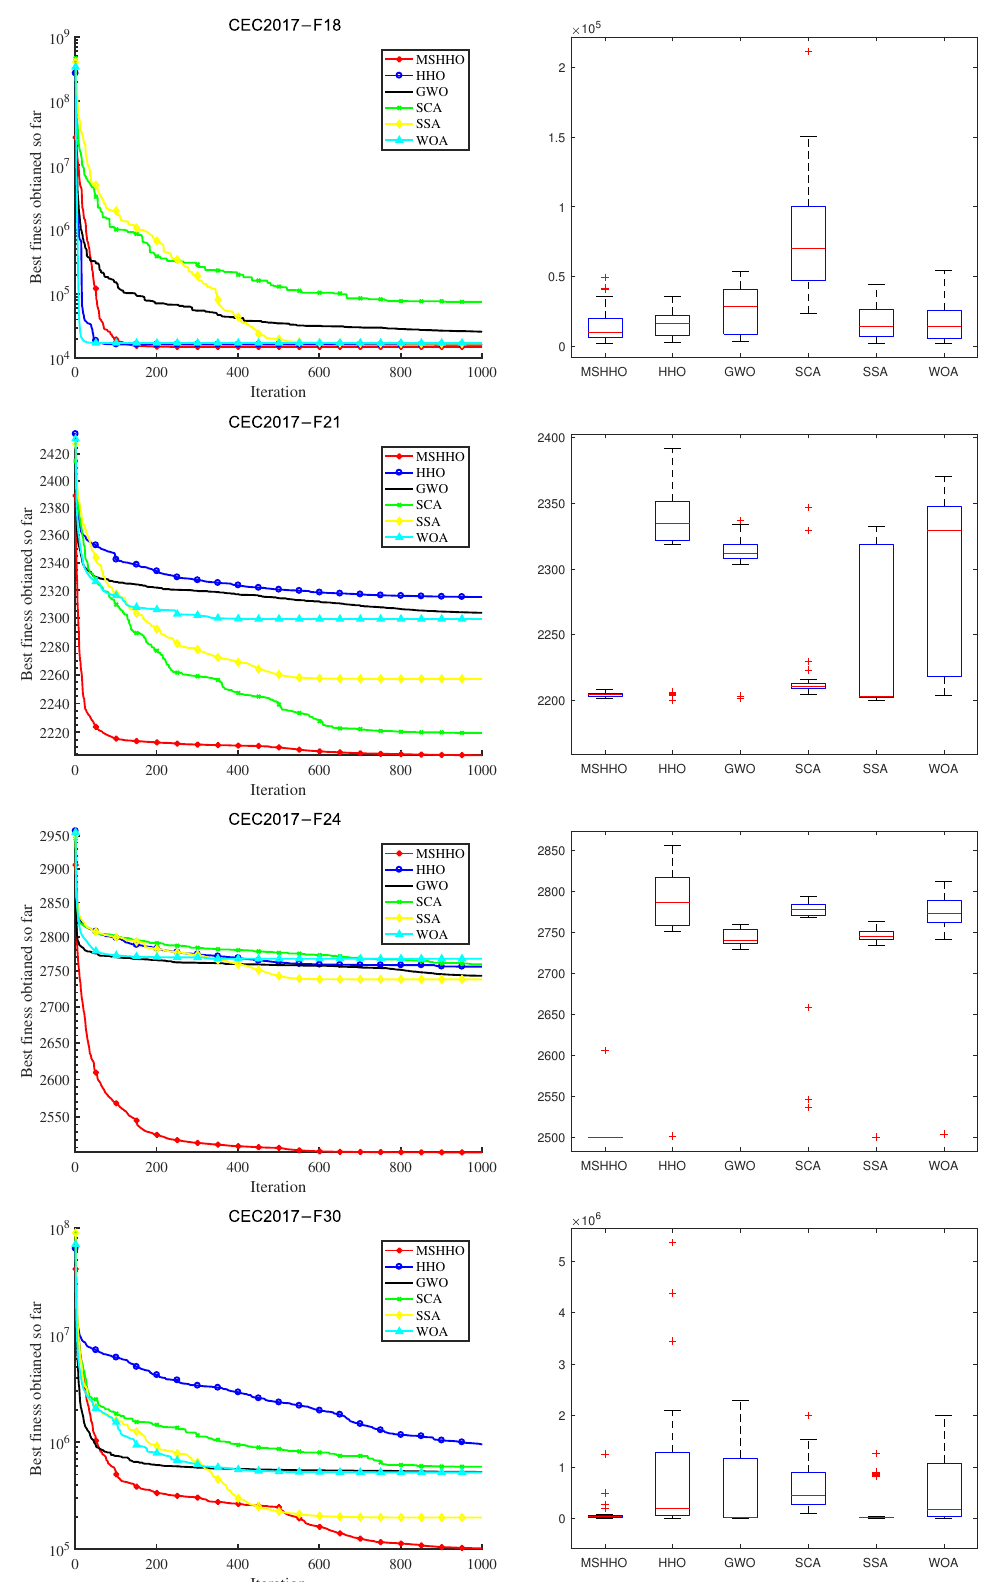
Figure 9. Qualitative results of F18, F21, F24, and F30